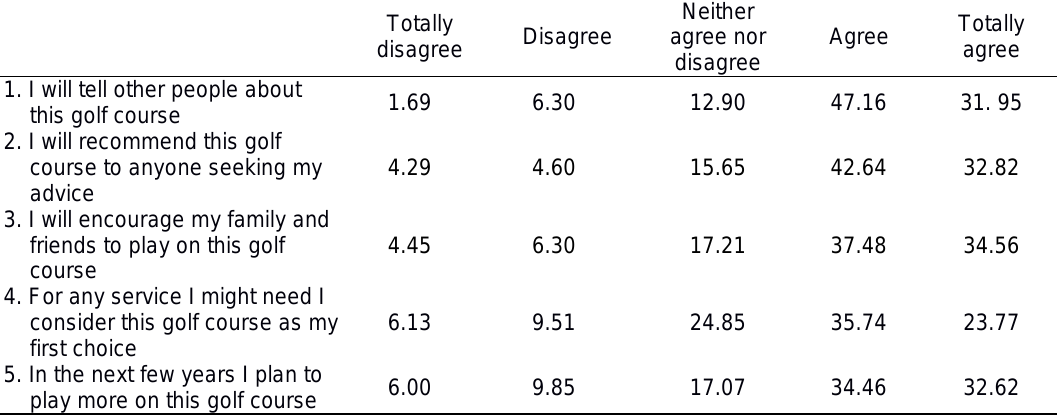
Table 1. Descriptive analysis of loyalty variables